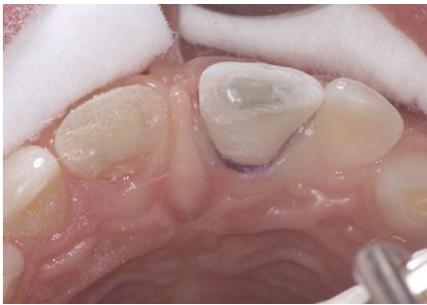
Figure 6: 2 weeks later, the glass ionomer was partially removed and direct composite restoration was